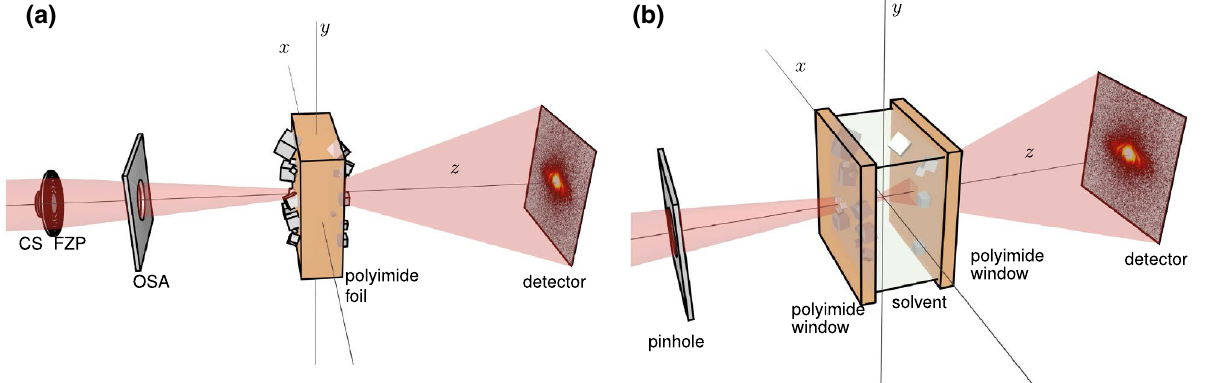
Figure 1. Schemes of the two experiments: ( a ) the ptychographic imaging experiment on a single polyimide foil: The central stop (CS), the Fresenel zone plate (FZP) and the order sorting aperture (OSA) are used to focus the coherent X-ray beam (red) on the polyimide foil with copper(I) oxide nanocubes deposited on both sides. ( b ) the ptychographic imaging experiment on the chemical reactor: the X-ray beam is focussed by a set of two 1D-focussing lenses (not shown), cleaned up by the pinhole, passes through the extended chemical reactor with particles on the downstream side of the upstream window and the upstream side of the downstream window and is finally measured in the far field by a photon counting pixel detector. In both experiments the sample is scanned perpendicularly to the beam (in x and y direction), while diffraction patterns are recorded in the